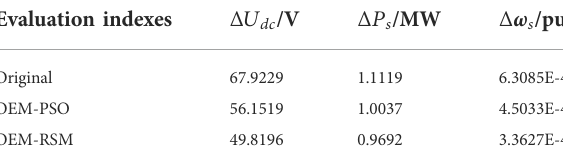
TABLE 10 Results of evaluation indexes with 3 parameter combinations. Evaluation